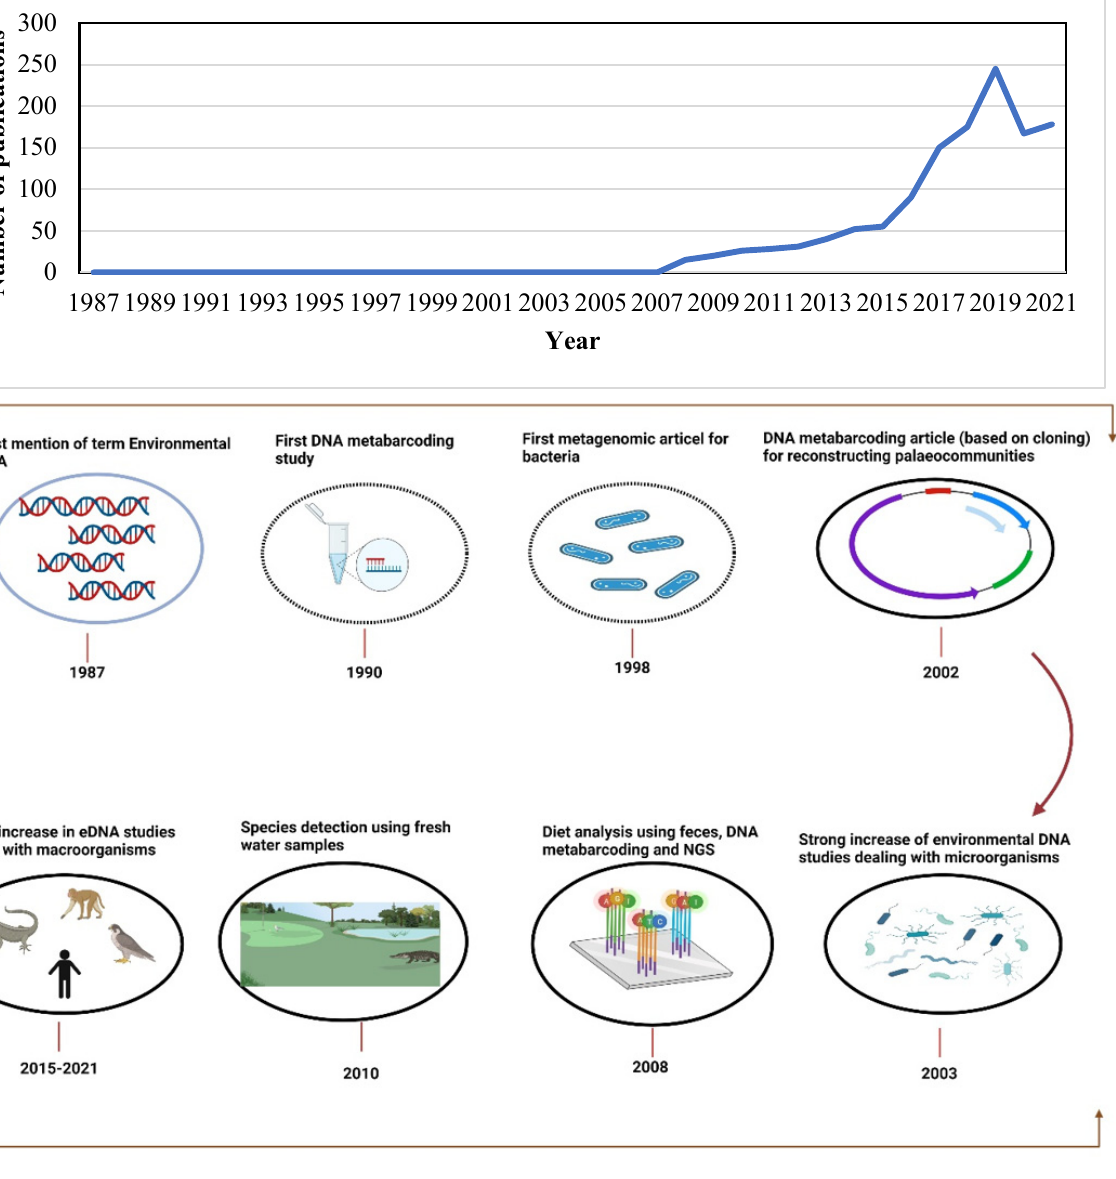
Figure 3. Using keywords ‘environmental DNA’, ‘eDNA’, ‘environmental DNA’, and ‘palaeoenvi- ronmental reconstruction’: the number of studies that contained one of these terms in their title, the keywords, or the abstract recovered from a literature search during the period between 1 January 2008 to July 2021.